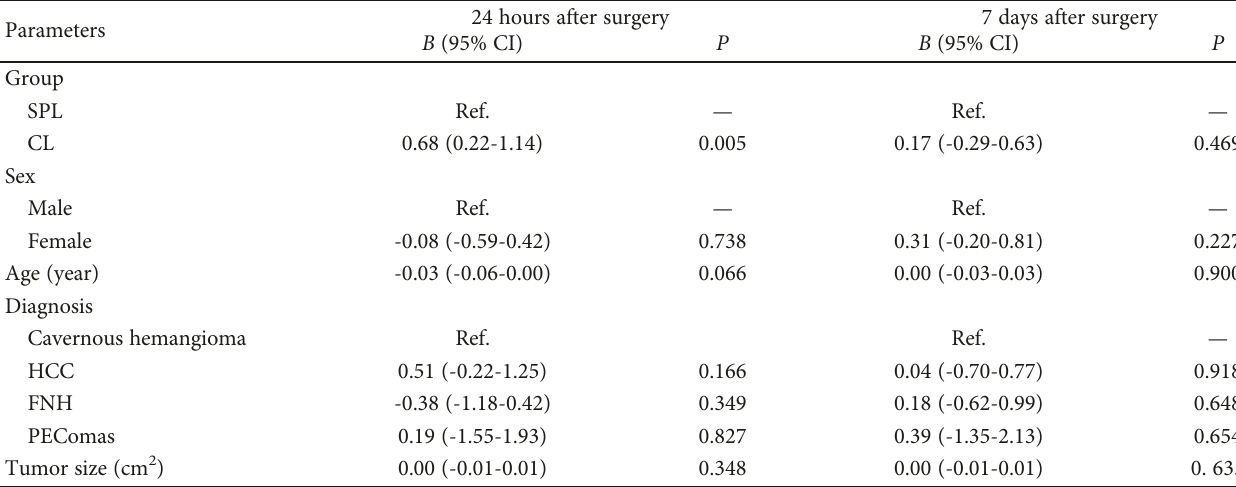
Table 3: VAS pain score compared between groups while covariates were